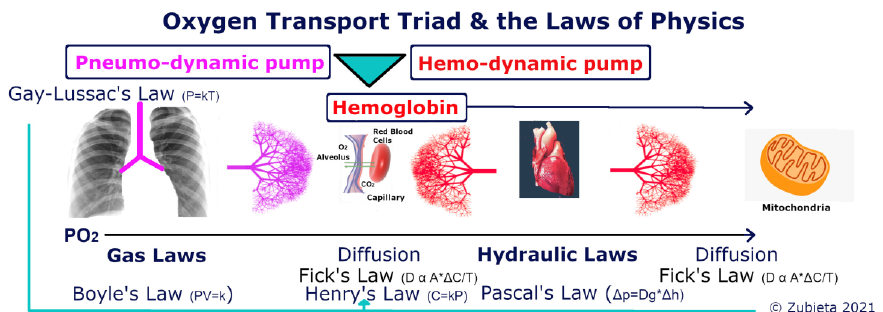
Figure 4. The Oxygen Transport Triad involves: the pneumo-dynamic pump, hemo-dynamic pump and Hemoglobin. The laws of physics applied to biology in each section are shown. It is important to note that Henry’s Law is effective in all sections: PIO 2 , PAO 2 , PaO 2, PtO 2 , and PmO 2